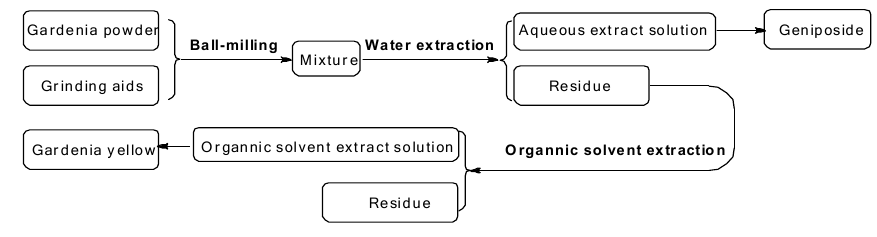
Figure 1. Process of the experiments.